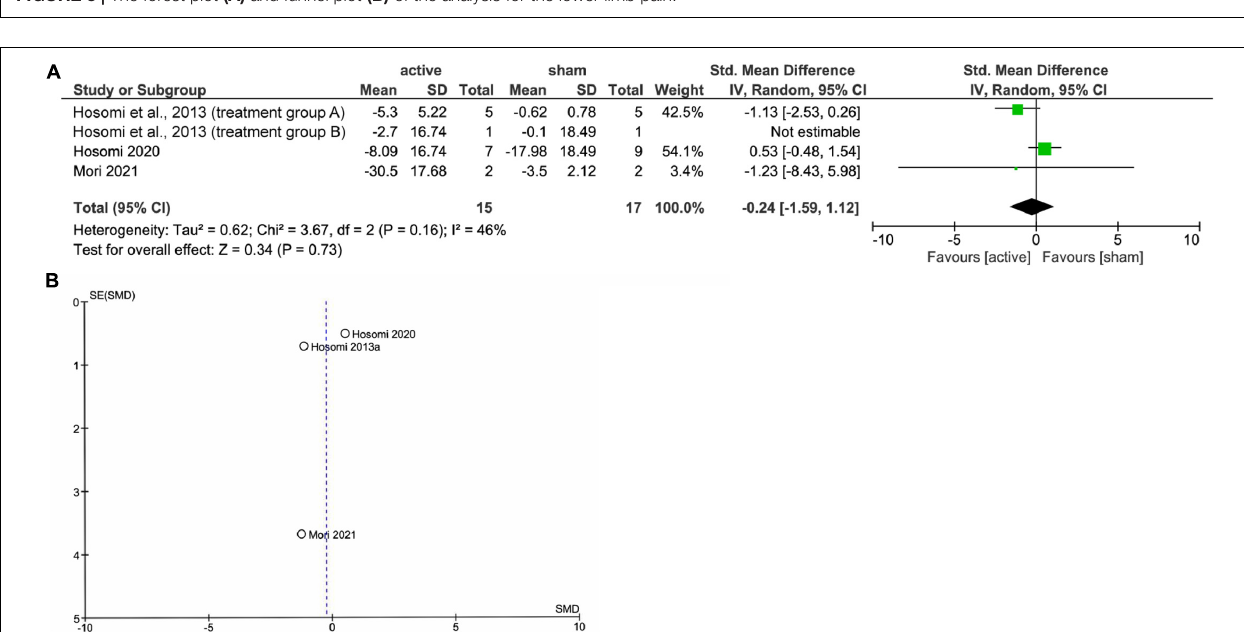
FIGURE 3 | The forest plot (A) and funnel plot (B) of the analysis for the lower limb pain.